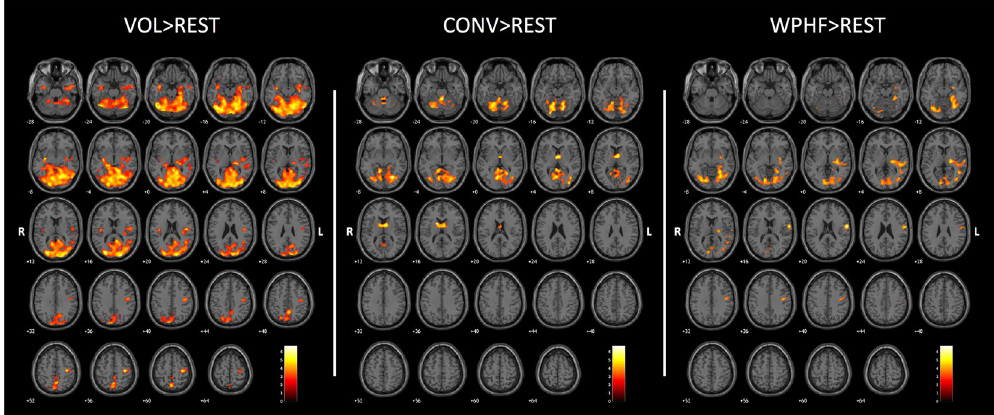
Figure 2. Group activation maps ( p < 0.005; k = 20; FDR corrected at cluster level p < 0.05) during VOL, CONV and WPHF protocols, compared to rest, performed at 10% of maximal voluntary contraction force. Statistical maps were coregistered with the SPM-MNI single subject T 1 images. The color scale represents the T values. R: right hemisphere; L: left